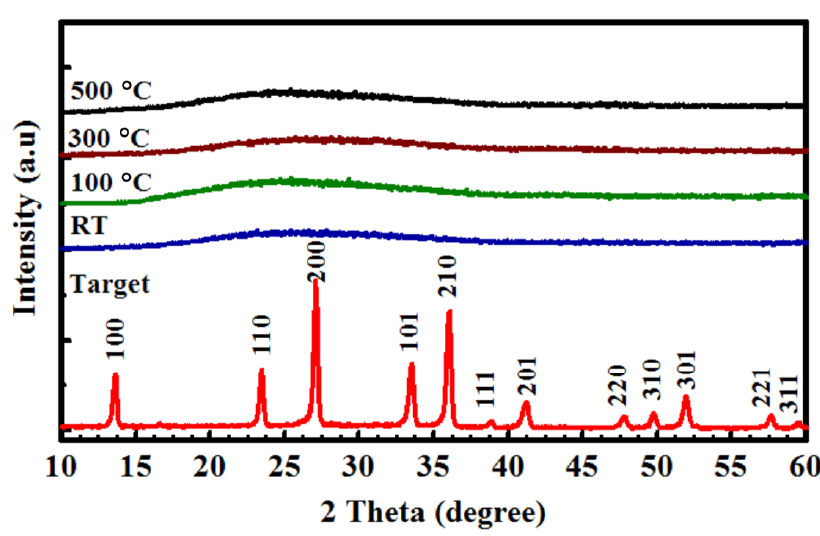
Figure 1. X-ray di ff ractometer (XRD) spectra obtained from Y / Sialon target prepared using spark plasma sintering (SPS) and Y / Sialon thin films fabricated using pulsed laser deposition (PLD).